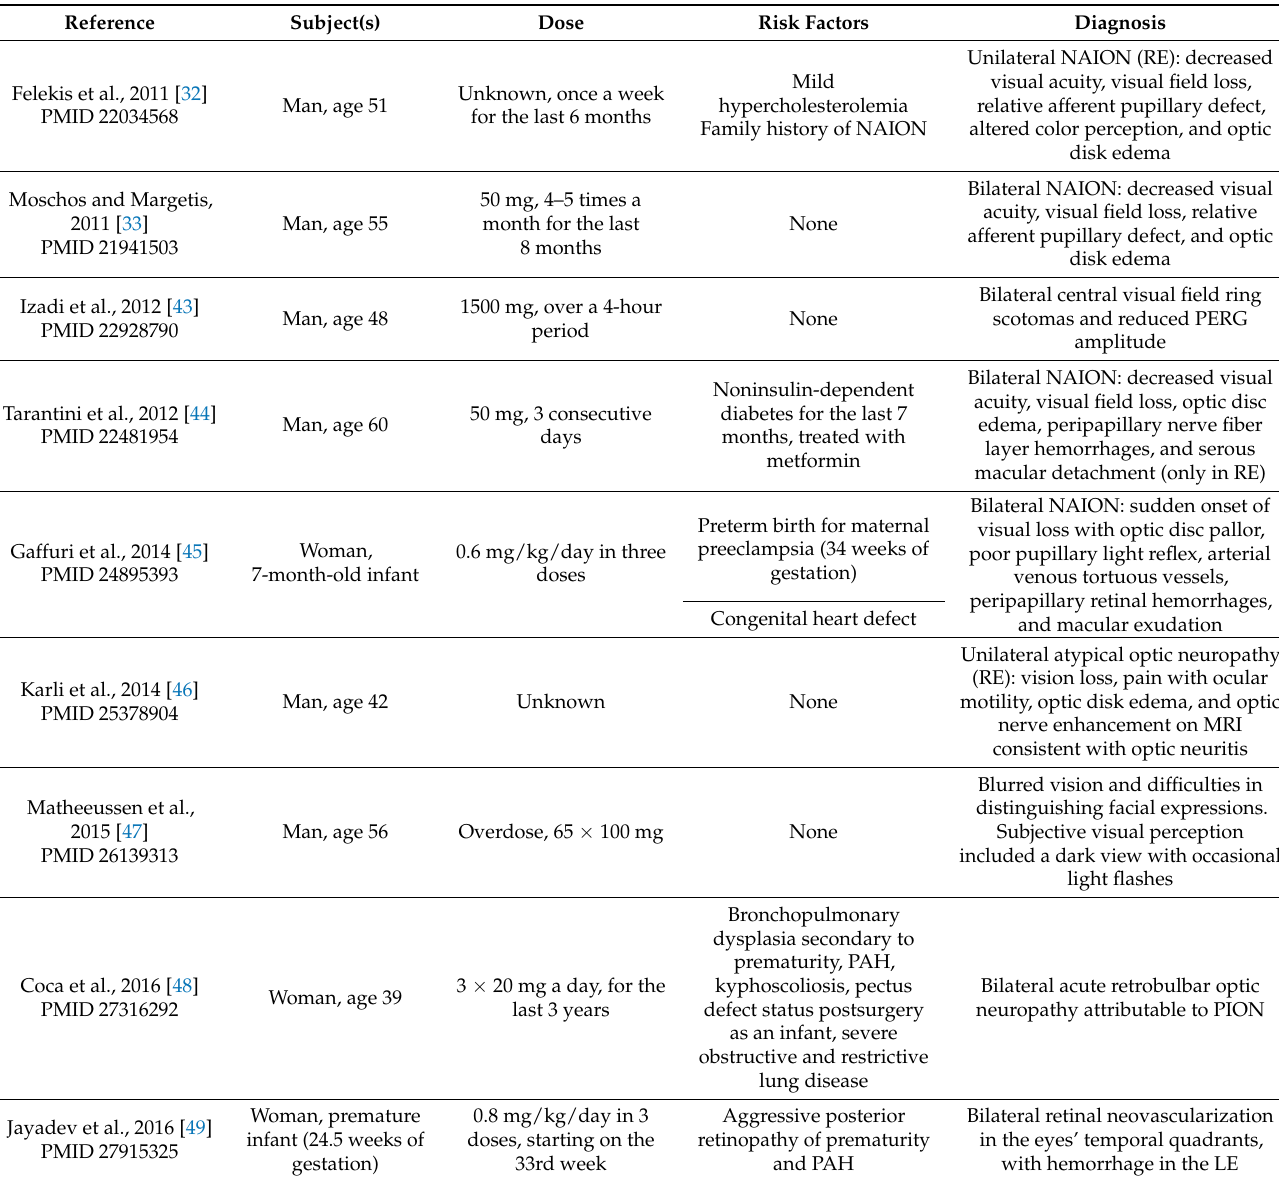
Table 2. Summary of case reports/series on sildenafil-induced visual side effects published on the last decade (2010–2020).